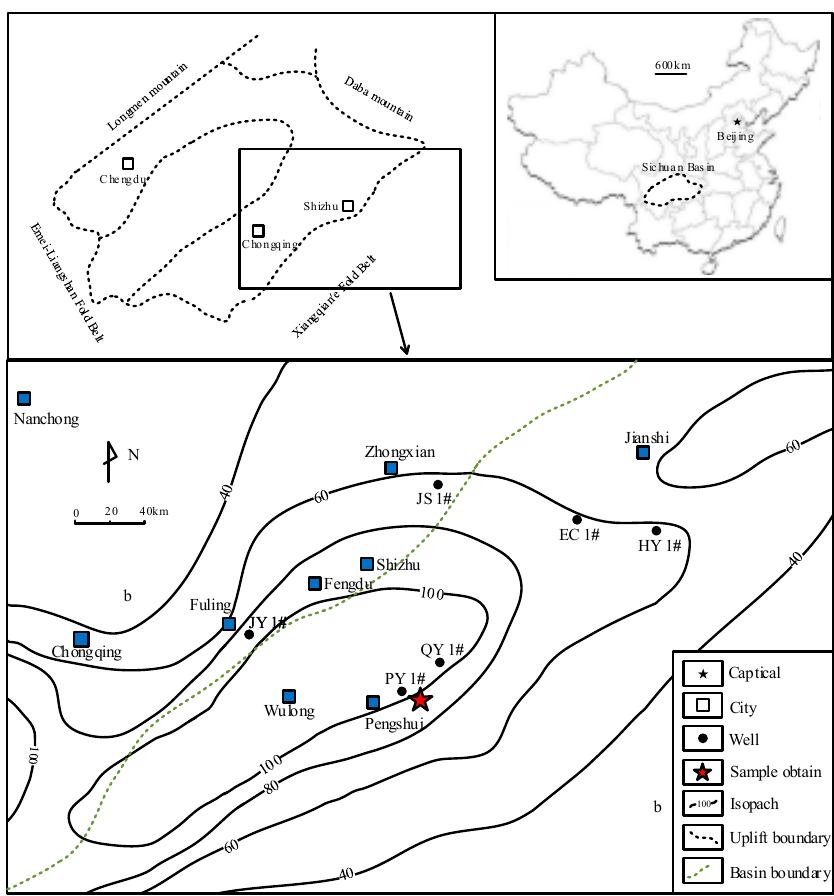
Figure 1. A sketch map of Lower Silurian Longmaxi shale in Southeast Chongqing. Table 1. Mineral composition of shale samples.